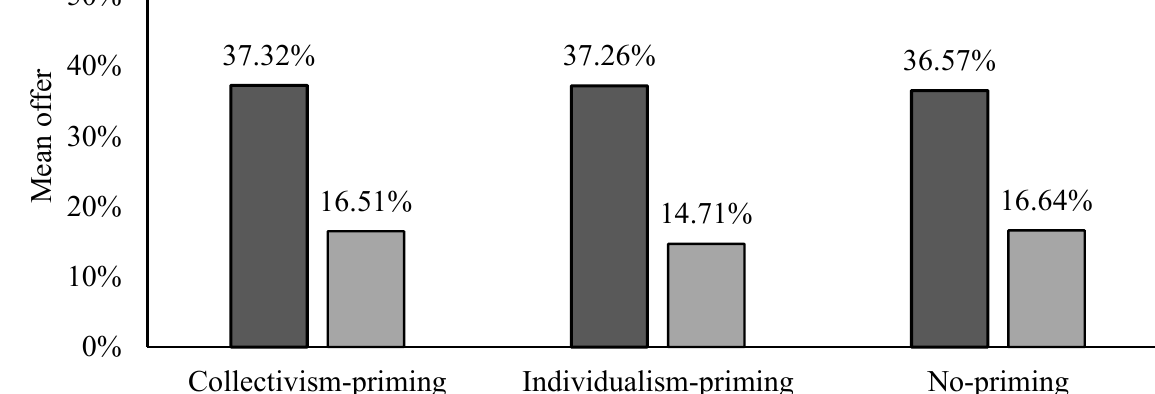
Figure 1. Comparison of mean offer.